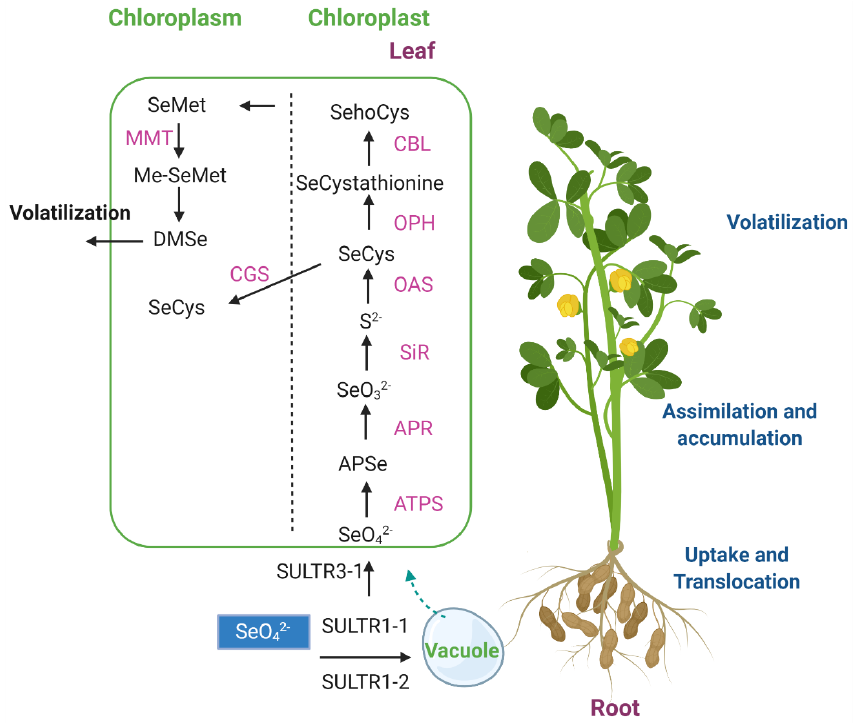
Figure 3. Scheme of main steps in selenium (Se) metabolism. SULTR: sulfate transporter; ATPS: ATP sulfurylase; APR: APS reductase; SiR: sulfite reductase; OAS: O -Acetyl Serine. OPH: O -phosphohomoserine; CBL: cystathione beta-lyase; MMT: S-adenosyl-L-Met:Met-S-methyltransferase; CGS: cystathione-c-synthase. Figure created with BioRender.com (accessed on 20th October 2021).